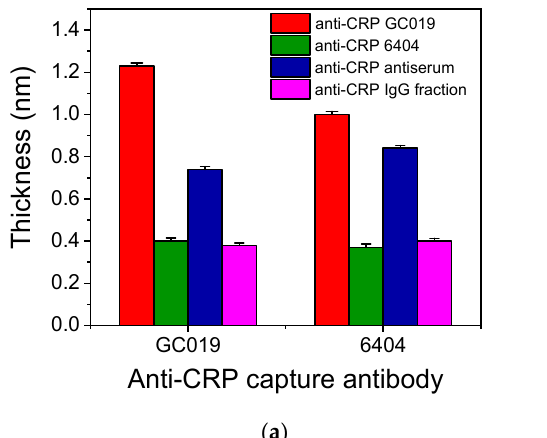
Figure 2. ( a ) Sensor responses obtained for a calibrator containing 100 ng/mL CRP using biochips coated with two different anti-CRP antibodies (GC019 or 6404) at a concentration of 100 µ g/mL in combination with four different detection antibodies all at a concentration 10 µ g/mL. Each point is the mean value of three measurements ± SD. ( b ) Sensor responses obtained for a calibrator containing 100 ng/mL CRP from chips coated with capture anti-CRP antibody at concentrations ranging from 20 to 400 µ g/mL. Each point is the mean value of three measurements ±